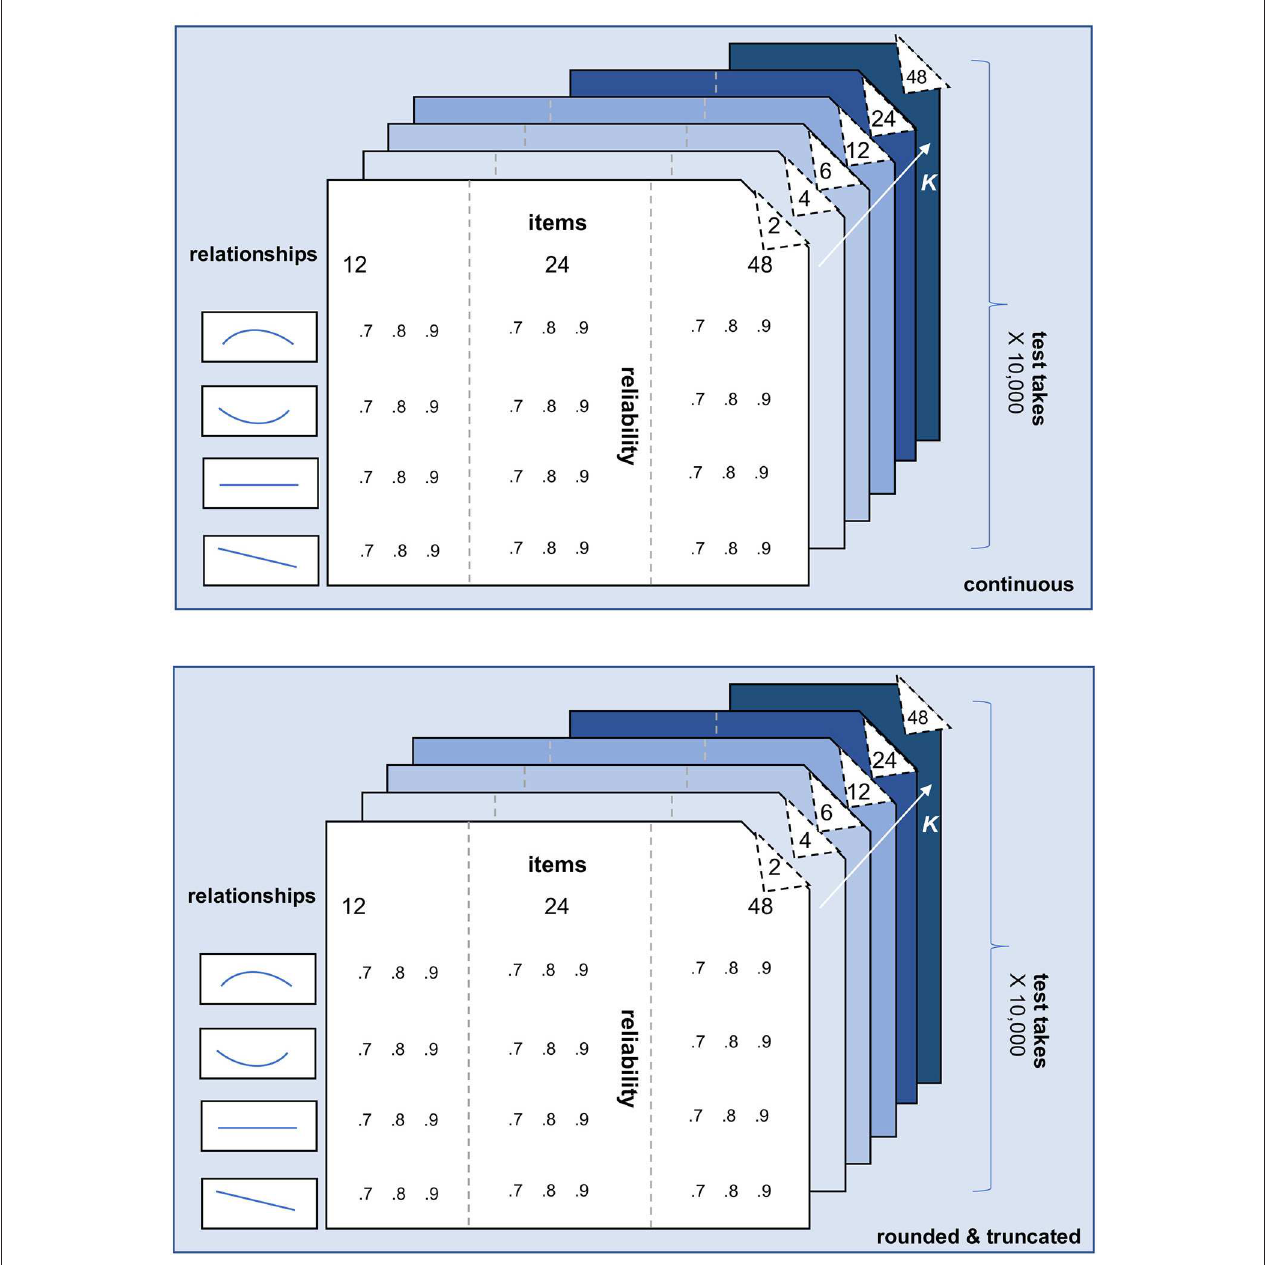
FIGURE 4 | Schematic overview of the simulation design. The characteristics number of repeated test takes (2), number of items (3), number of parallel test parts K (4), relationship between “true” test score and error variance (5), and overall test reliability (6) are varied for both the scenario with continuous test scores (1; upper part of the figure) and rounded and truncated test scores (lower part of the figure). Each slide within “continuous” and “rounded and truncated” belongs to a specific number of parallel test parts K . Within each slide ≤ K = 12, 3 (number of items) × 4 (relationships) × 3 (reliabilities) = 36 conditions are being simulated. The slides K = 24 and K = 48 add another 24 ( K = 24) and 12 ( K = 48)